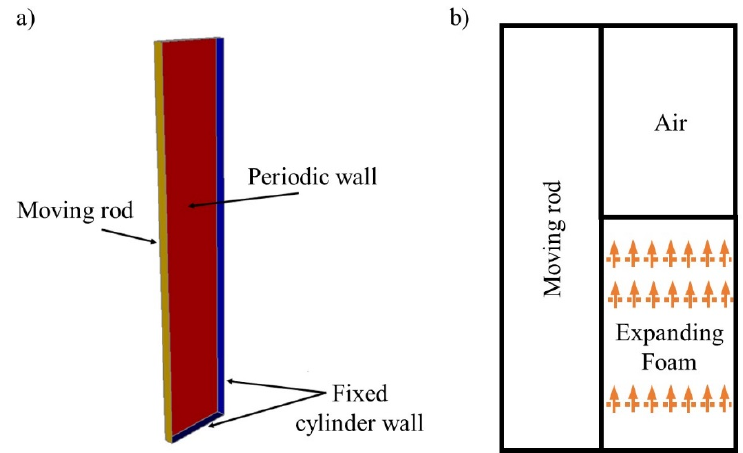
Figure 2. ( a ) 3D slab geometry used in simulations of PUR foam expansion and its torque evaluations and ( b ) setup of the mixed domain used for estimating the thermal condition at the transition area between rod and foam.